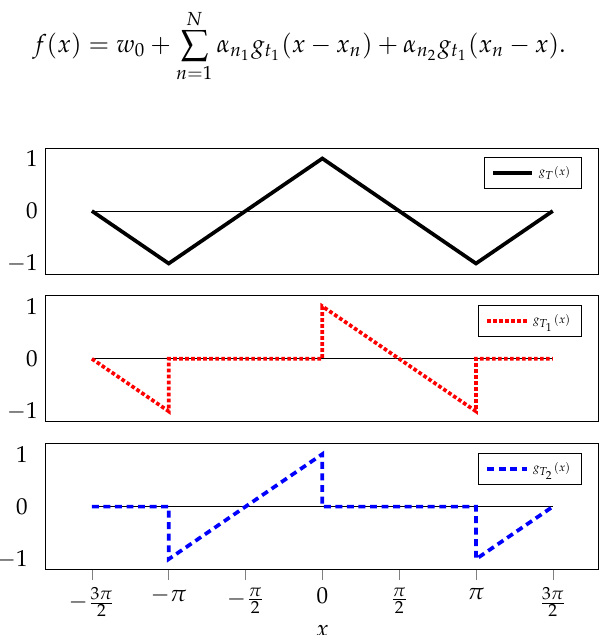
Figure 6. Decomposition of the triangle wave.